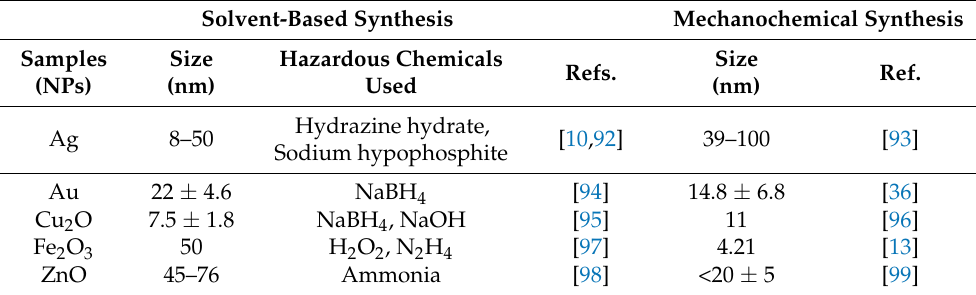
Table 1. Comparative study of solvent-based synthesis and mechanochemical synthesis of vari- ous NPs. Solvent-Based Synthesis Mechanochemical Synthesis